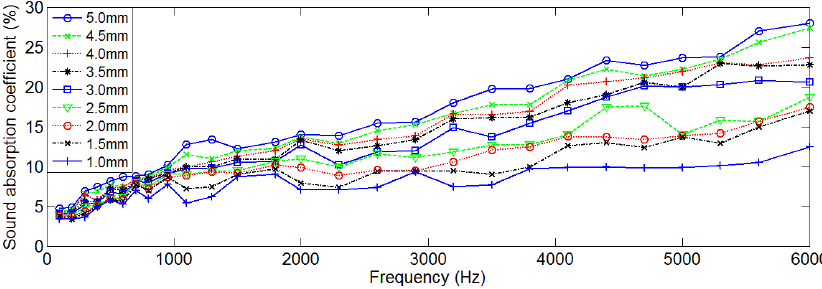
Figure 4. Comparisons of sound absorption coefficients of single sample with different compression ratios.